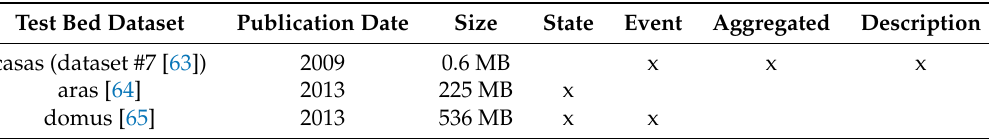
Table 2. Comparison of open datasets from smart home test